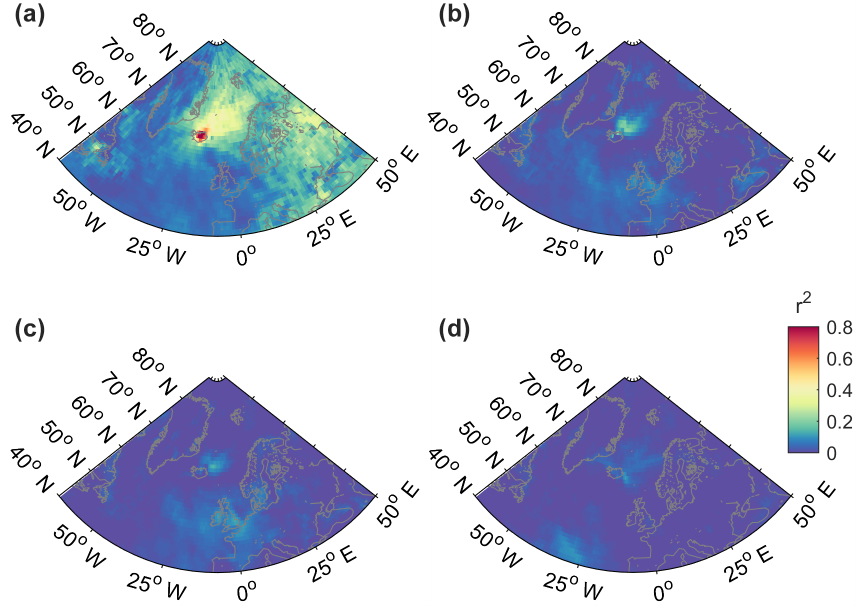
Figure 11. Coefficient of determination r 2 for monthly time series (1990–2016) of dust deposition and emission (a) , dust deposition normal- ized by total emission and emission in N Iceland (b) , dust deposition normalized by total emission and emission in S Iceland (c) and dust deposition and the NAO index (d) .